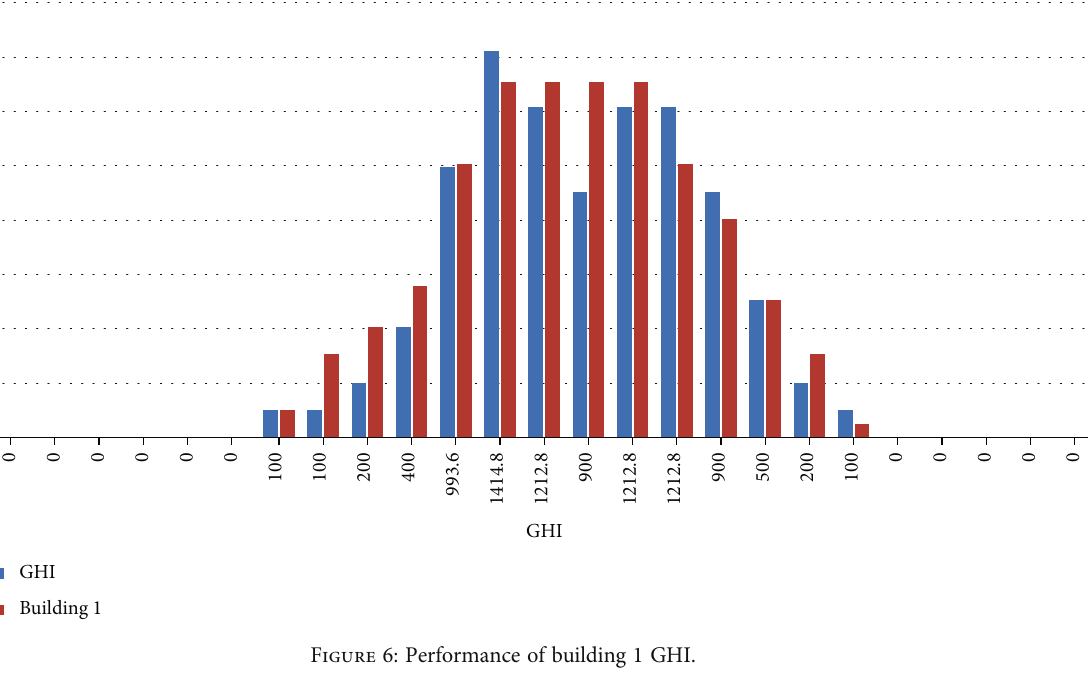
Figure 6: Performance of building 1 GHI.